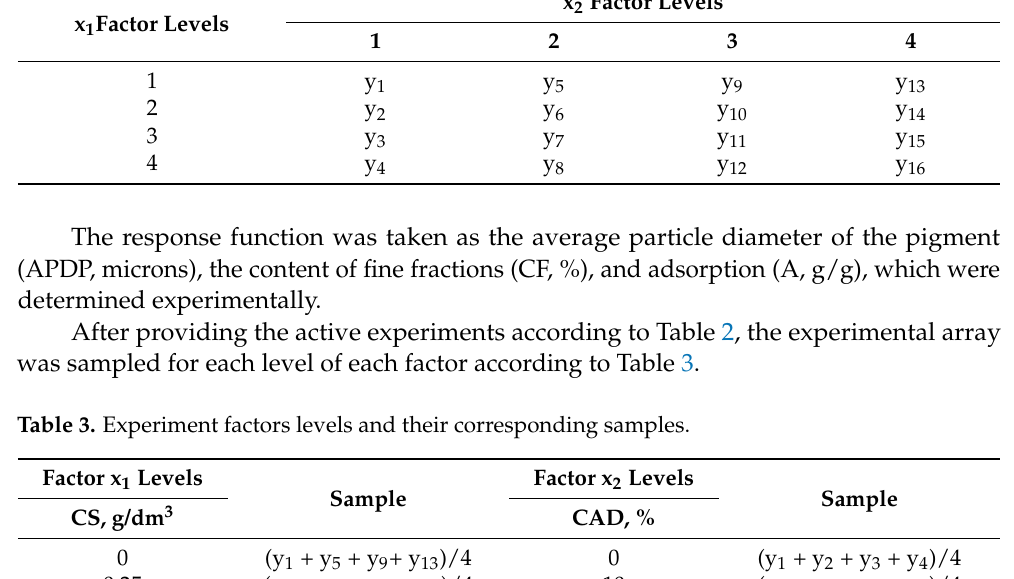
Table 2. General view of a multilevel design matrix of a two-factor experiment. x 1 Factor Levels